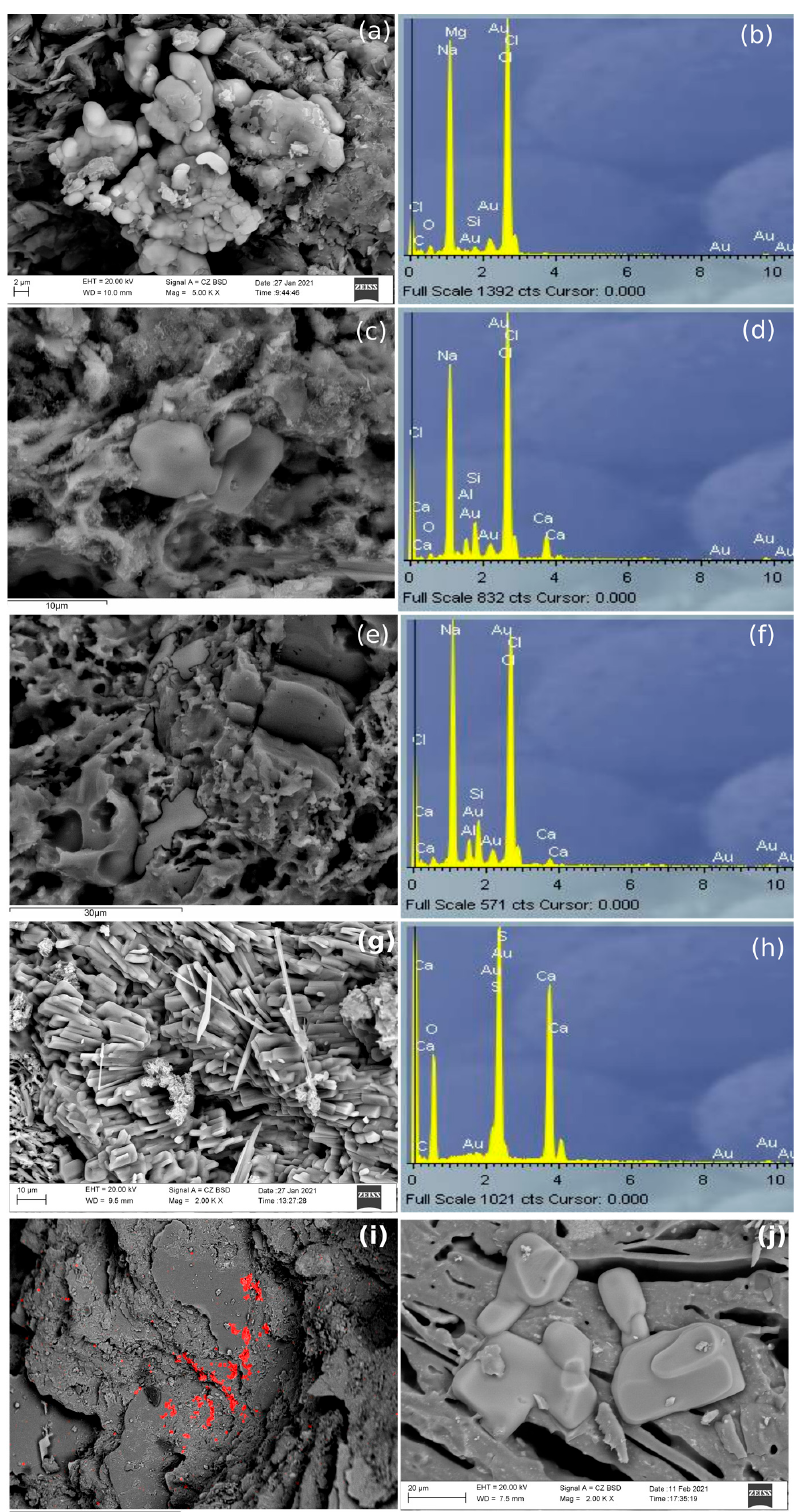
Figure 6. SEM-BSD image of the fractured surfaces of PT and PF marine samples and their elemental analyses by EDS. ( a–f ) aggregates composed of Na and Cl, suggested to be NaCl. They appear in different forms; ( g , h ) aciculate crystals composed of Ca, S, O, suggested to be a calcium sulphate; ( i ) NaCl (marked in red) in top of big mineral phases of AP002: ( j ) NaCl in the cavities of AP015.